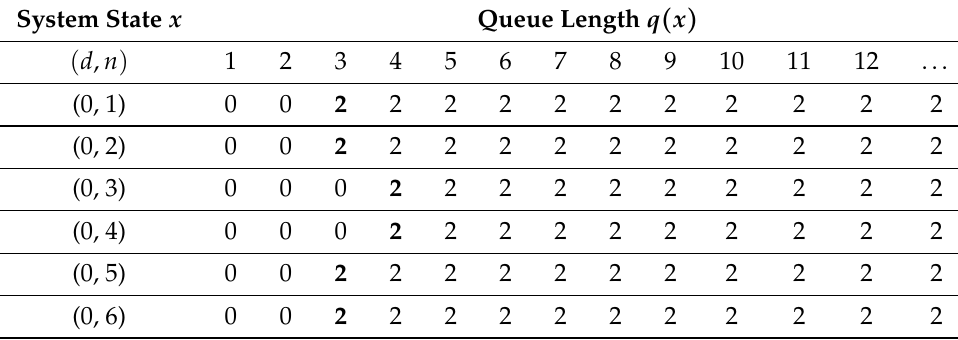
Table 2. Control policy f l − k